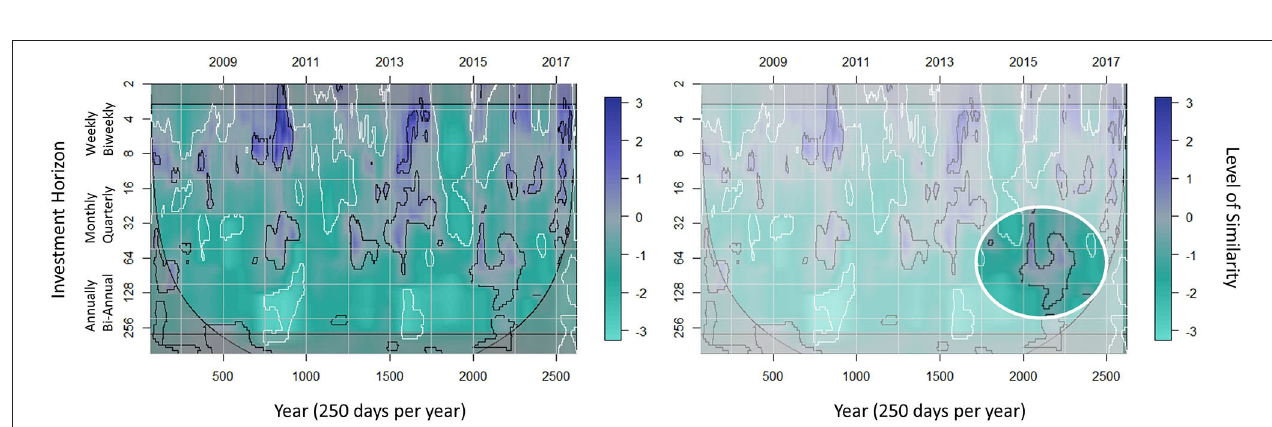
FIGURE 7 | The WSD of the water-energy nexus (left) and energy and S&P500 (right) . The more purple the color, the higher the similarity is between time series. The black-line regions are regions of statistical significance at the 5% level (high similarity) and the white-line regions are regions of statistical significance at the 95% level (low similarity) estimated using Monte Carlo simulations. The box and thin black region are the border effects and define the cone of influence, respectively. Here we are using a fixed time radius of 64 days and the investment horizon radius (window margins) is determined by the length of the series.